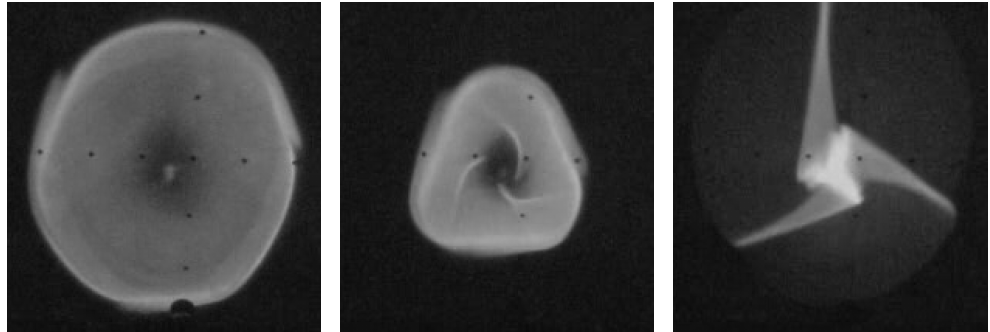
Figure 5. A magnetic solenoid behind ion beam extraction focuses the beam shown in Figure 4 onto a VT. Only singly charged Helium, m / q = 4 is